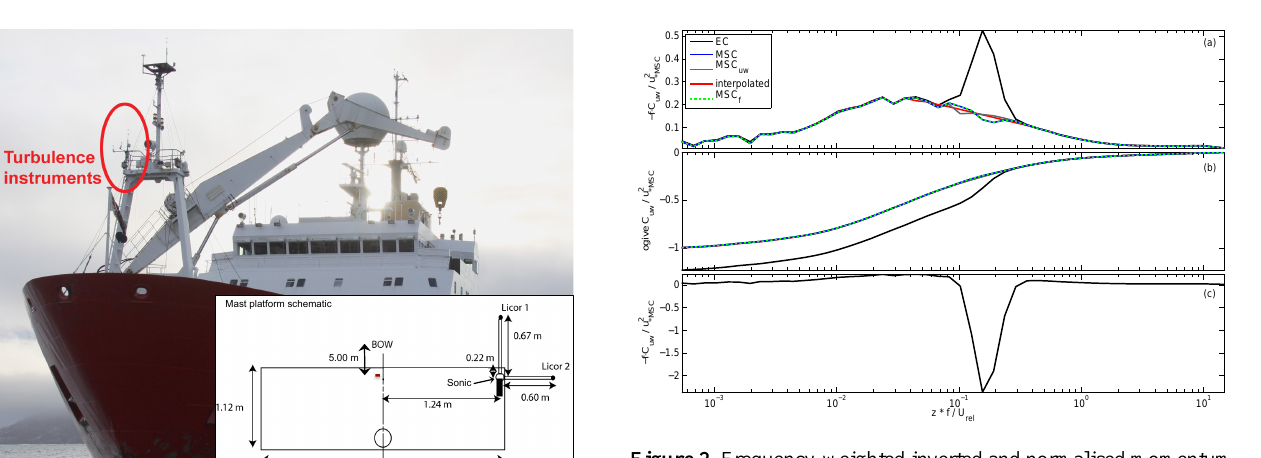
Figure 2. Frequency-weighted inverted and normalised momentum flux cospectra (a) and normalised ogives (b) , shown relative to non- dimensionalised frequency using measurement height z and mean Figure 3. Layout of the foremast instrumentation. The top panel shows the view from the bridge looking forwards. The platform is 14.5 m above the sea surface (for a ship’s draught of 5.6 m). Figure 1. Locations of the flux instrumentation on the RRS James relative wind speed U rel . Also shown are frequency-weighted, in- Clark Ross . The sonic anemometer is 2.0m above the starboard for- verted and normalised cospectra calculated prior to motion correct- 2.2 WAGES Mean meteorological sensors The WAGES mean meteorological sensors were installed after the first mobilisation cruise, ward corner of the platform. Note that the forecastle crane is gen- ing the turbulent velocity components, which results in a large up- during the refit in late August 2010. The on-board automated processing merged air temperature and humidity from ship sensor 1 (Section 2.3) on to the other data streams from the start of the WAGES erally stowed close to the deck while the ship is underway or on campaign in May 2010 until the 3rd April 2012, after which data from the ship's sensor 2 were wards flux signal at the motion scale (c) . Results shown are an av- station. erage of 131 30min duration measurements at mean wind speeds 10ms − 1 < U 10n < 14ms − 1 . EC indicates the cospectra after re- moving platform motion following Edson et al. (1998) and shows the residual signal at scales typical of the wave field. The interpo- lation across the wave scales has been applied between frequencies of 0.04 and 0.4Hz. The motion-scale correction (MSC) can either be applied as per Eq. (2) (MSC), with Eq. (2) applied to both the along and vertical wind components (MSC uw ) , or as described by Edson et al. (2011) (MSC f ) . Normalisation of the five different sets of results is by u ∗ with MSC applied as per Eq. (2). Note that the MSC f line overlies the MSC line at all frequencies, and the inter- polated, MSC uw and EC lines overlie at frequencies away from the